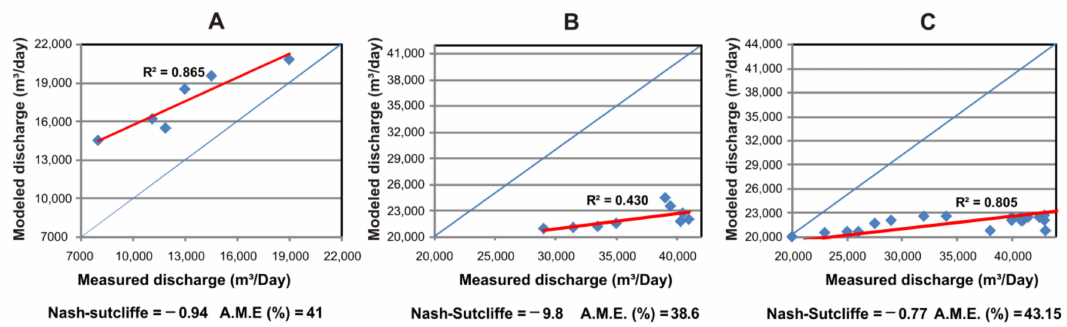
Figure 7. Measured versus modeled drainage discharge for the calibration ( A ), verification ( B ), and inverse modeling ( C